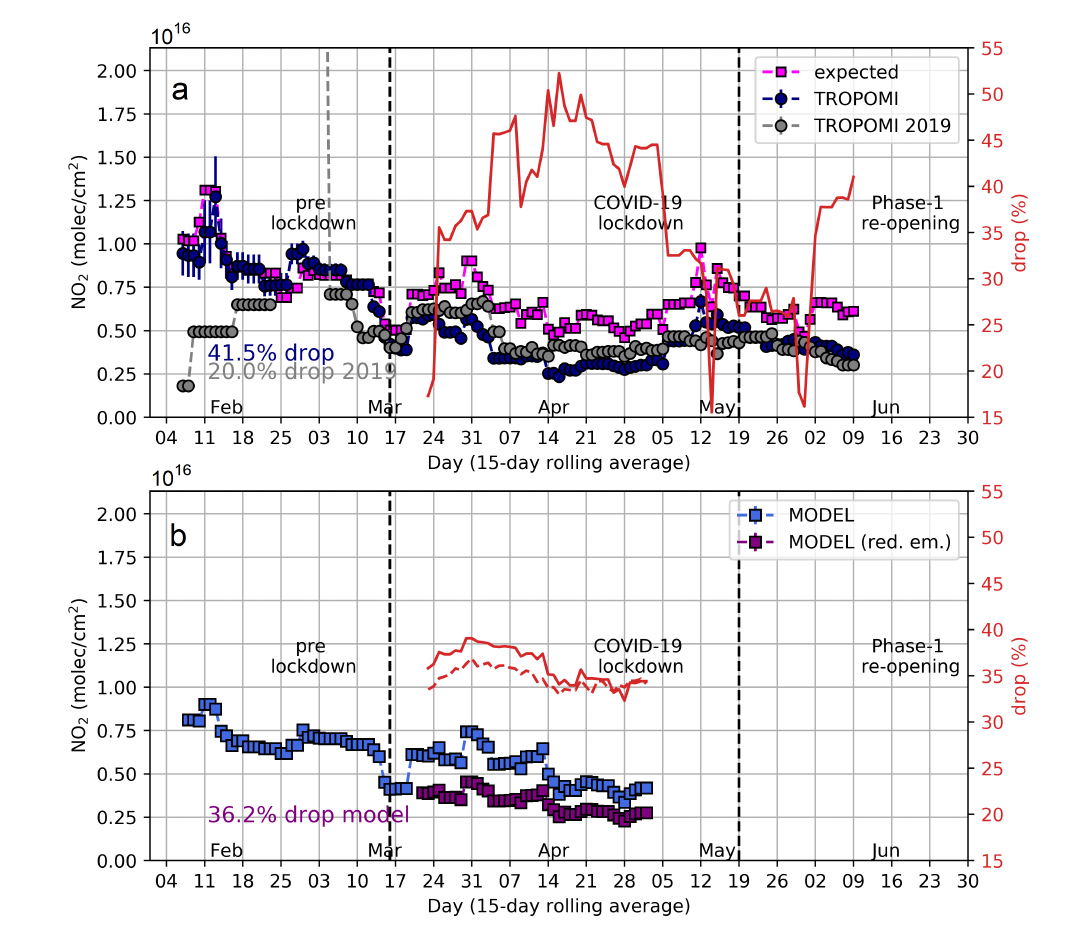
Figure 4. Timeseries of 15-day running mean of NO 2 VCDs over Toronto and Mississauga for 7 February to 9 June 2020, panel ( a ) shows the TROPOMI observations (navy), the expected columns (magenta). The timeseries of 2019 TROPOMI observations (grey) for the same period is shown as a reference. The red line indicates the percentage emission reductions based on the difference between the TROPOMI observations and expected columns. Panel ( b ) shows NO 2 columns from the model predictions sampled like TROPOMI assuming a BAU scenario with 2020 updated emissions (blue) and a 2020 COVID reduced emissions scenario (purple). The percentage decrease in model predicted VCDs (red line) is estimated from the difference between the two model runs, the red dashed line shows the drop for perfect sampling. Average emission reductions are highlighted using observations between 16 March to 8 May 2020. Approximately 200 observations are averaged for the 15-day mean, the resulting standard errors are plotted, however, the standard error is seen to be small and on the order of 10 13 –10 14 molec/cm 2